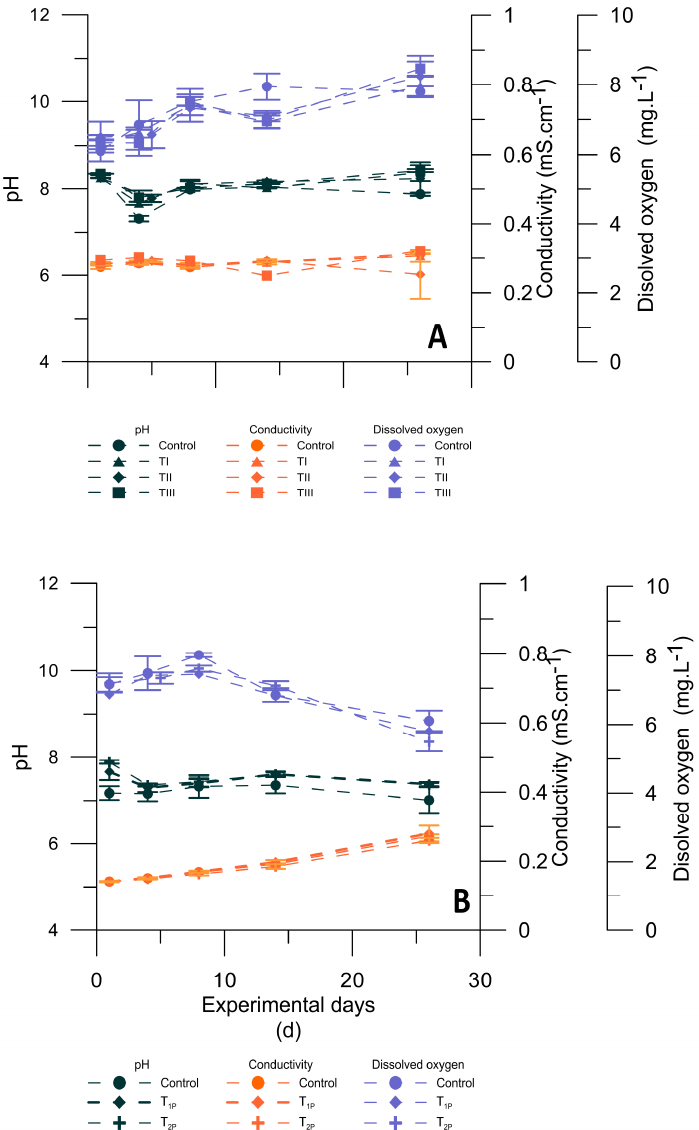
Figure 1. Physicochemical variables recorded in situ at each microcosm during the first experiment (sample-2017; ( A )) and the second experiment (sample-2018; ( B )): dissolved oxygen (mg · L − 1 ), pH and conductivity (mS · cm − 1 ). Values are the means of triplicates, and vertical lines on the top of symbols represent the standard deviations.